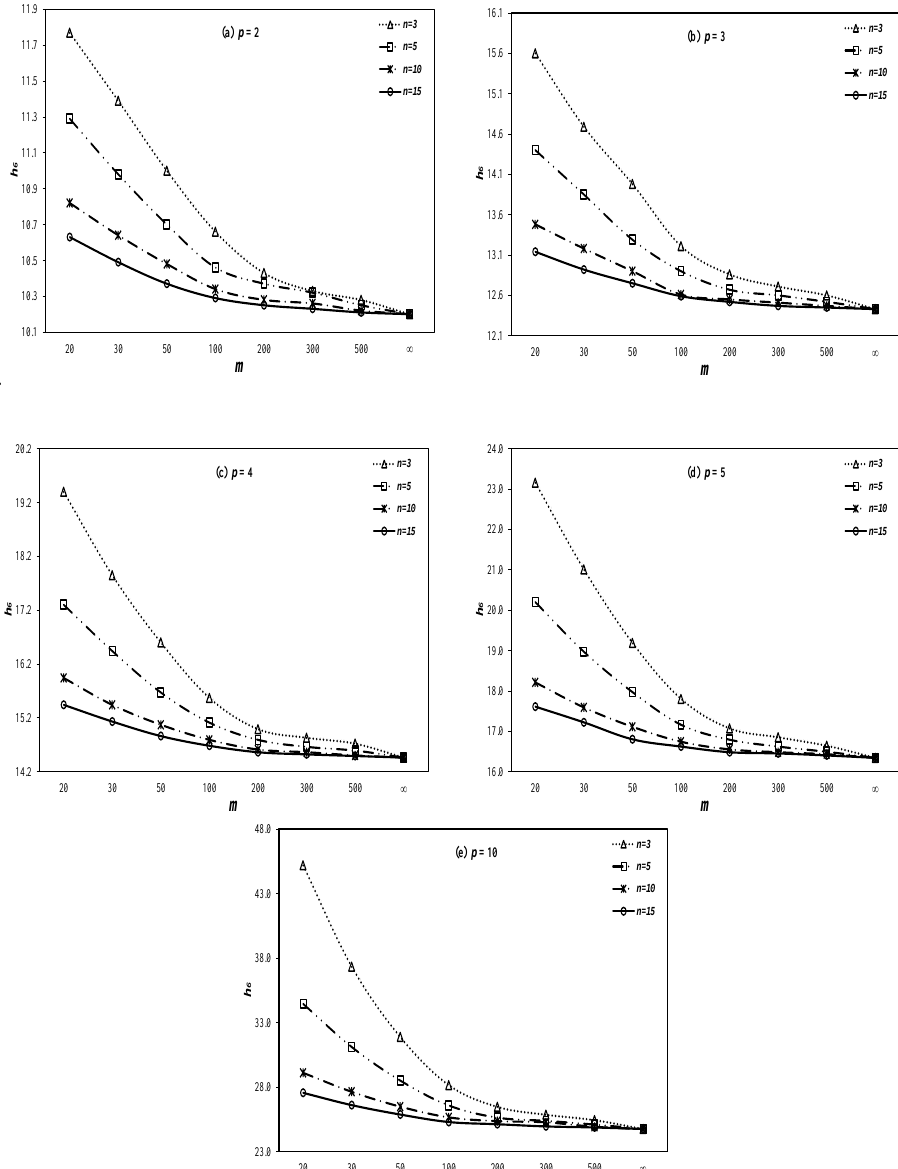
Figure 7. Control limit curves of proposed chart under estimated parameters with λ = 0.2 .